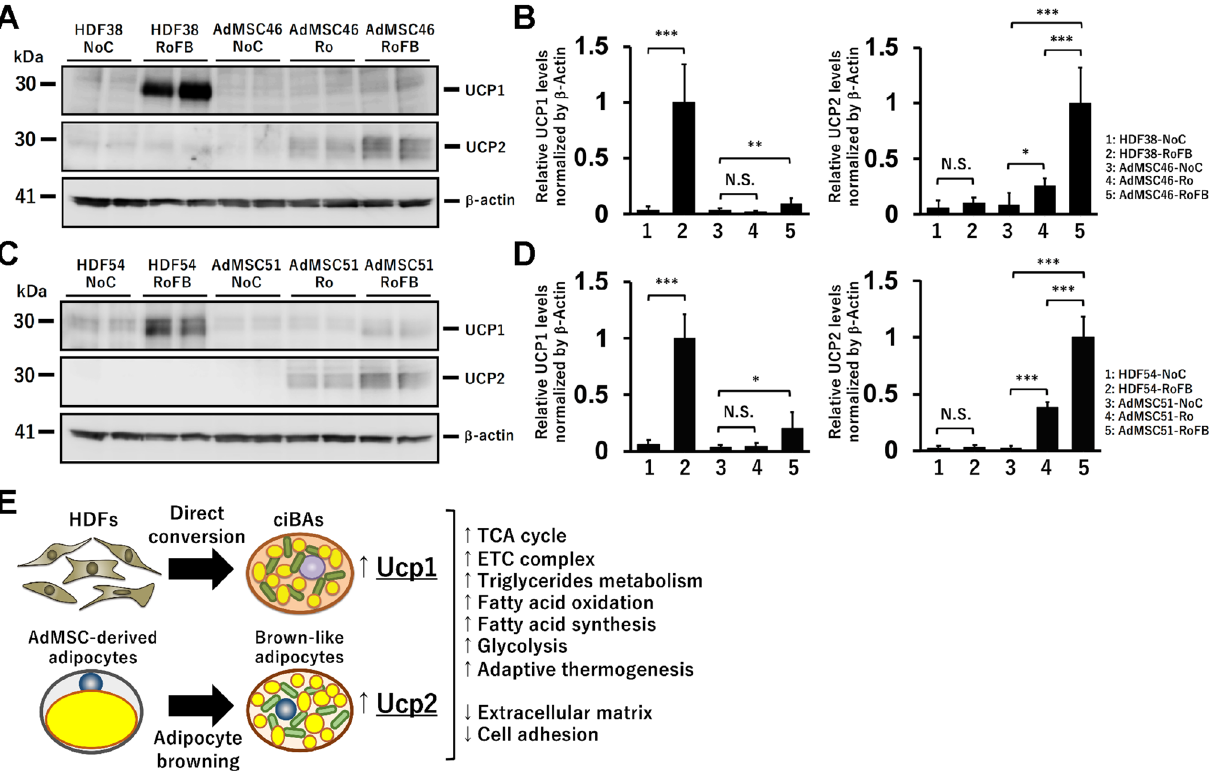
Figure 7. Comparative expression pattern of UCP1 and UCP2 proteins in ciBAs and AdMSC-derived adipocytes. ( A ) The protein levels of UCP1 and UCP2 were quantified by immunoblotting in the adipocytes derived from HDF38 and AdMSC46. ( B ) The band intensities were measured by densitometry using ImageJ software. Full length blots are presented in Supplementary Fig. S7. β-Actin protein was used as a loading control for normalization. Data represent mean ± SD (n = 6). Student’s t-test: *P < 0.05, **P < 0.01, ***P < 0.001, N.S. not significant. ( C , D ) The protein levels of UCP1 and UCP2 were quantified in a different set of the adipocytes derived from HDF54 and AdMSC51. ( E ) A summary of transcriptome analysis in the comparison between the direct conversion to ciBAs and the adipocyte browning of AdMSC. In both biological pathways, a series of genes were activated in functional groups such as related to energy metabolism, mitochondria, and adaptive thermogenesis, while many fibrogenic genes involved in extracellular matrix and cell adhesion were repressed. These results suggested that the direct conversion to ciBAs underwent genome-wide transcriptional changes similar to the adipocyte browning of AdMSC. One of the most characteristic differences between them was the expression pattern of major uncoupling proteins. ciBAs more strongly expressed Ucp1 responsible for adrenergic thermogenesis in brown/beige adipocytes, while the AdMSC-derived adipocytes predominantly expressed Ucp2 with a weaker uncoupling activity and other